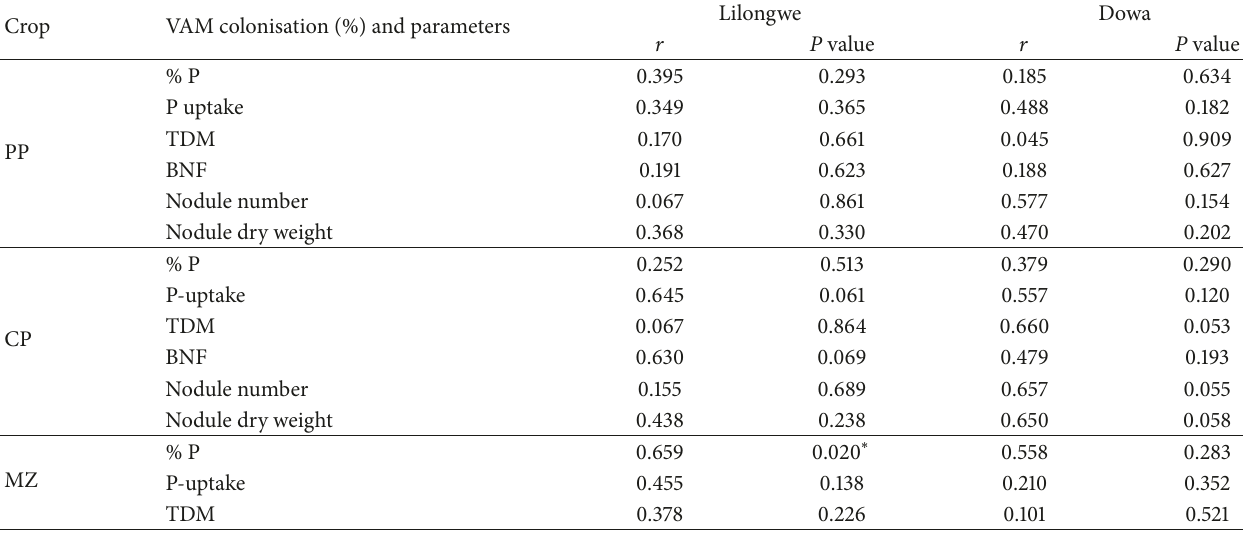
Table 2: Pearson correlations between colonisation percentages and plant tissue P concentration, P uptake, total dry matter yields, BNF/plant, nodule number, and nodule dry weights for year one.